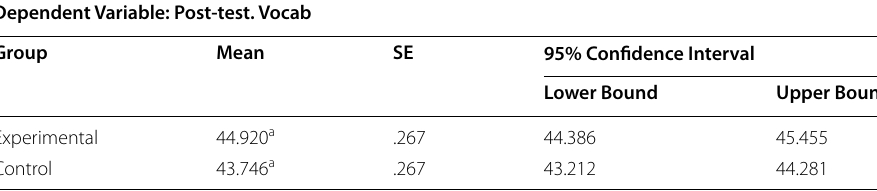
a Covariates appearing in the model are evaluated at the following values: Pre-test. Vocab Table 11 Tests of Between-Subjects Effects (Non-parametric Quade’s ANCOVA) Dependent Variable: Unstandardized